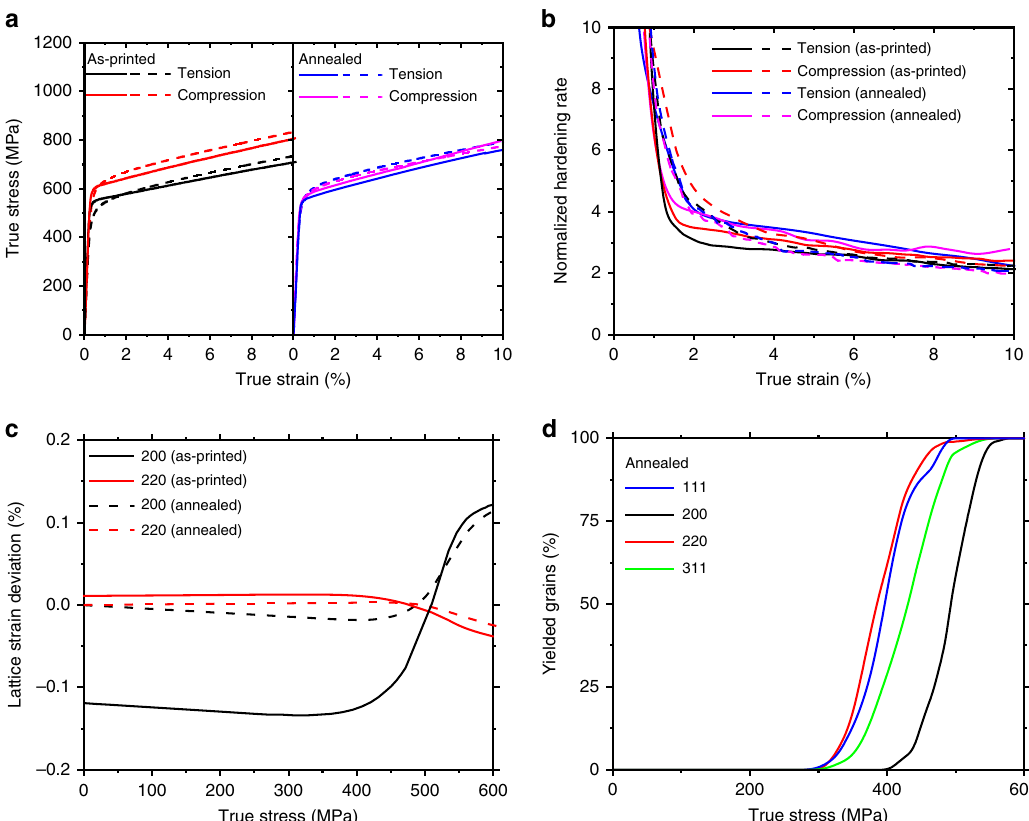
Fig. 6 CPFE results of tension – compression asymmetry of AM stainless steel. a Comparison of true stress – strain curves under uniaxial tension and compression from experiment (solid lines) and simulation (dashed lines) for as-printed and annealed samples. b Comparison of normalized strain hardening rate vs. true strain under uniaxial tension and compression from the experiment (solid lines) and simulation (dashed lines) for as-printed and annealed samples. c Simulated lattice strain deviation ( Δ ε hkl ) as a function of applied stress for {200} and {220} grain families for as-printed and annealed samples under uniaxial tension. d Simulated volume fraction of plastically yielded grains within each family against the macroscopic true stress in the annealed sample, showing progressive plastic yielding among different grain